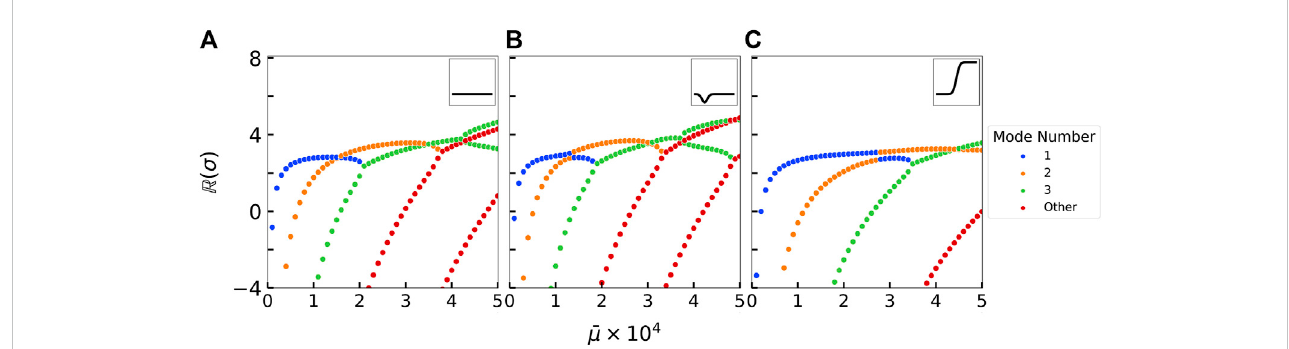
FIGURE 5 Eigenspectrumstabilitymapsforthreedifferentrigiditypro fi lesthathighlightthestabilityofeachmodeasafunctionoftheelastoviscousnumber (cid:2) μ . (A) is constant rigidity B 1 ( s ), (B) is locallyweak stiffness pro fi le B 2 ( s ),and (C) is asymmetrically rigid stiffness pro fi le B 3 ( s ). Positive growth rates ( R ( σ ) > 0 ) correspond tounstablemodes.Modesarecolor-codedbasedontheirmodenumberwith “ OtherModeNumber ” indicatingfourthandhighermodes.Dataplottedonthe graphs are plotted in increments of 1,000 (cid:2) μ . Insets show stiffness pro fi les corresponding to each eigenspectrum map.